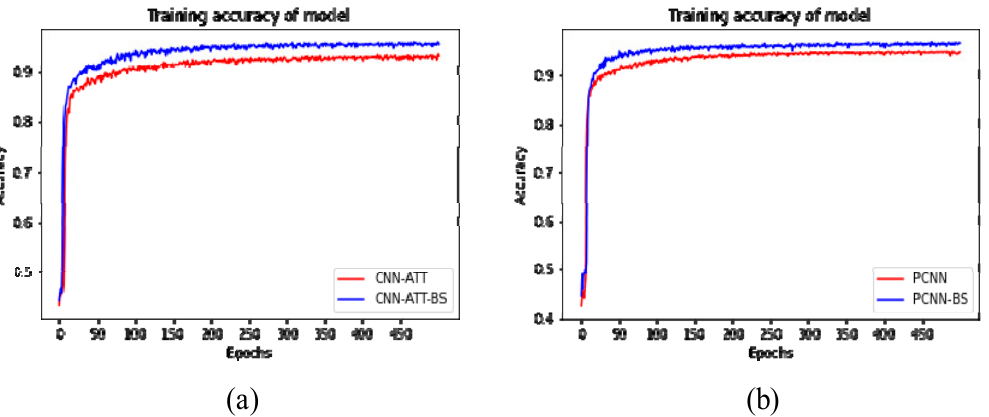
Figure 9. Accuracy comparison before and after the addition of the band selection module. ( a ) Accuracy of CNN–ATT before and after adding the band selection module; ( b ) accuracy of PCNN before and after adding the band selection module.